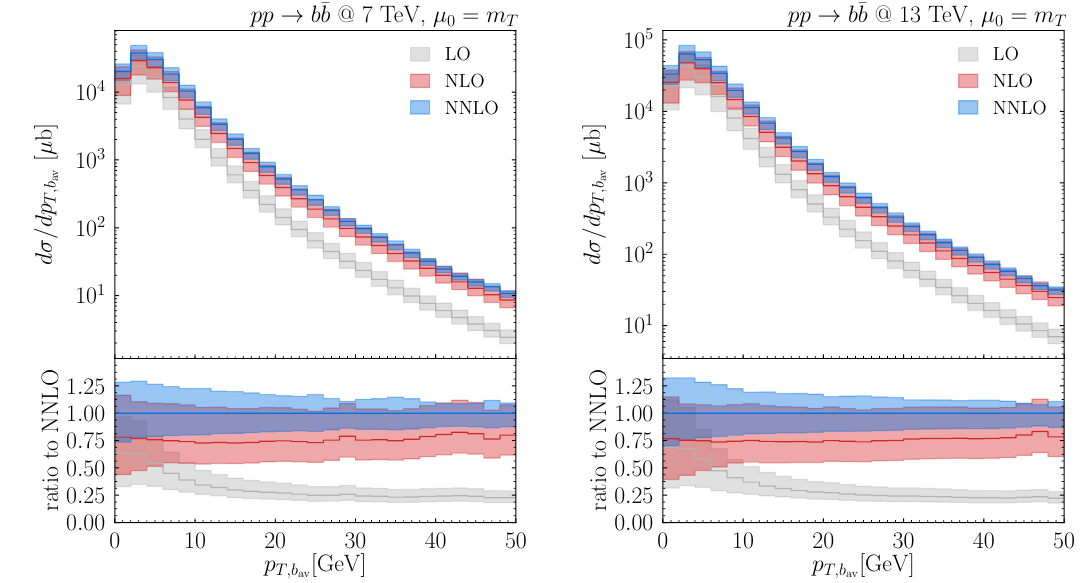
Figure 4 . Transverse momentum distribution at the LHC for the scale choice (cid:22) 0 = m T , for p s = 7 TeV (left) and 13 TeV (right). The lower panels show the ratio to the NNLO